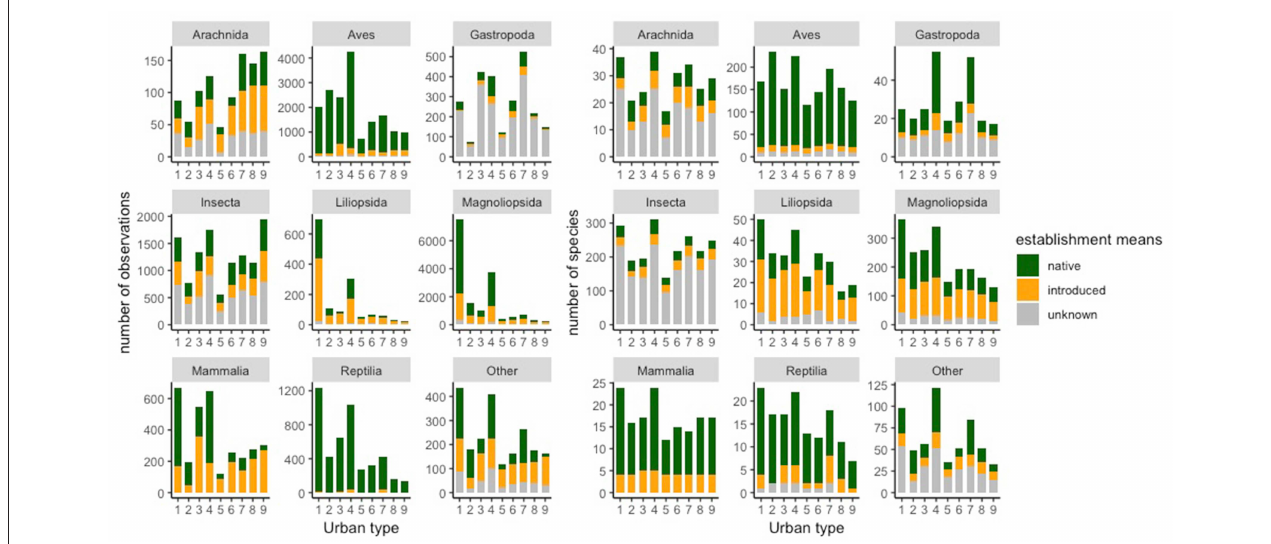
FIGURE 5 | Summary of iNaturalist data by select taxa in each urban habitat